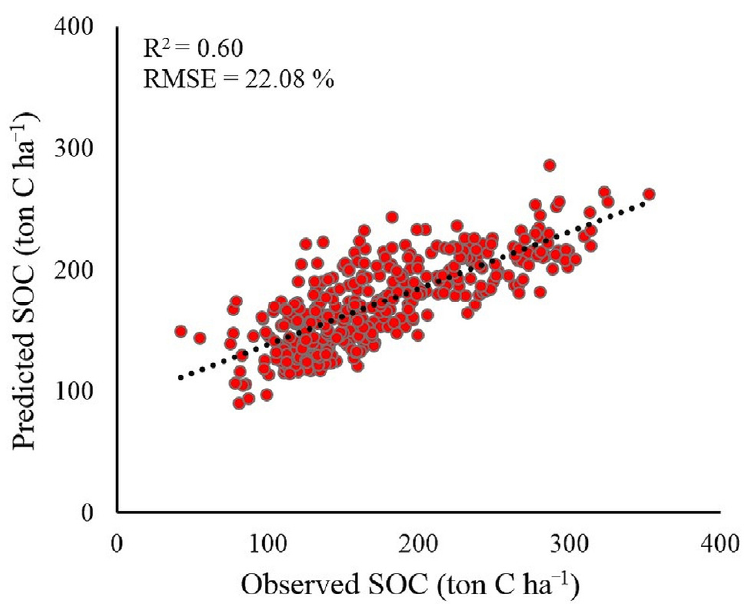
Figure 2. Scatterplots for the regression model of soil organic carbon content (SOC), with fitted line indicated in dashes.